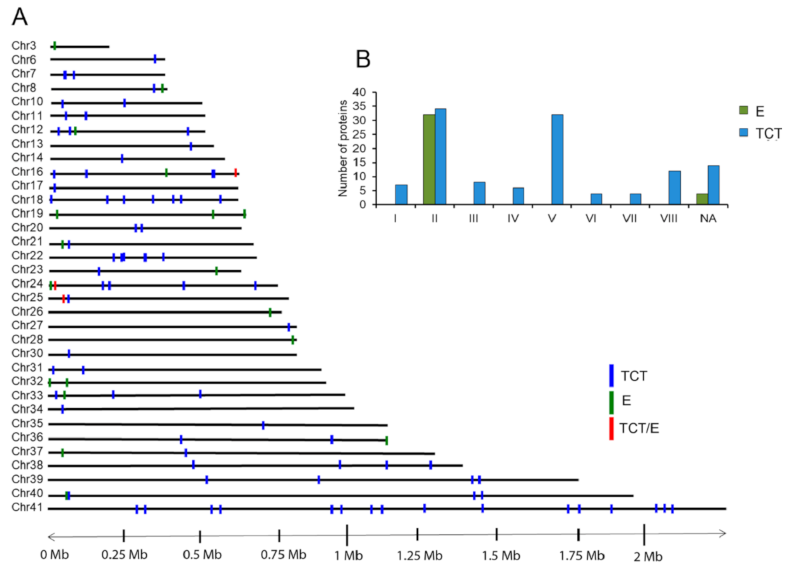
Figure 3. Mapping of TS proteins found in EVs of E and EVs of TCT of T. cruzi Pan4 strain on T. cruzi CL-Brener strain chromosomes. ( A ) Genomic mapping of TS on chromosomes represented as blue bars for TS of trypomastigote forms derived from cell cultures, green bars for TS of epimastigotes or red bars for TS genes present in both stages (TCT: n = 121; E: n = 36). ( B ) Bar graph representing the TS proteins found in the EVs of TCT and EVs of E and categorized for the CL-Brener strain in groups I–VII, according to Freitas et al.